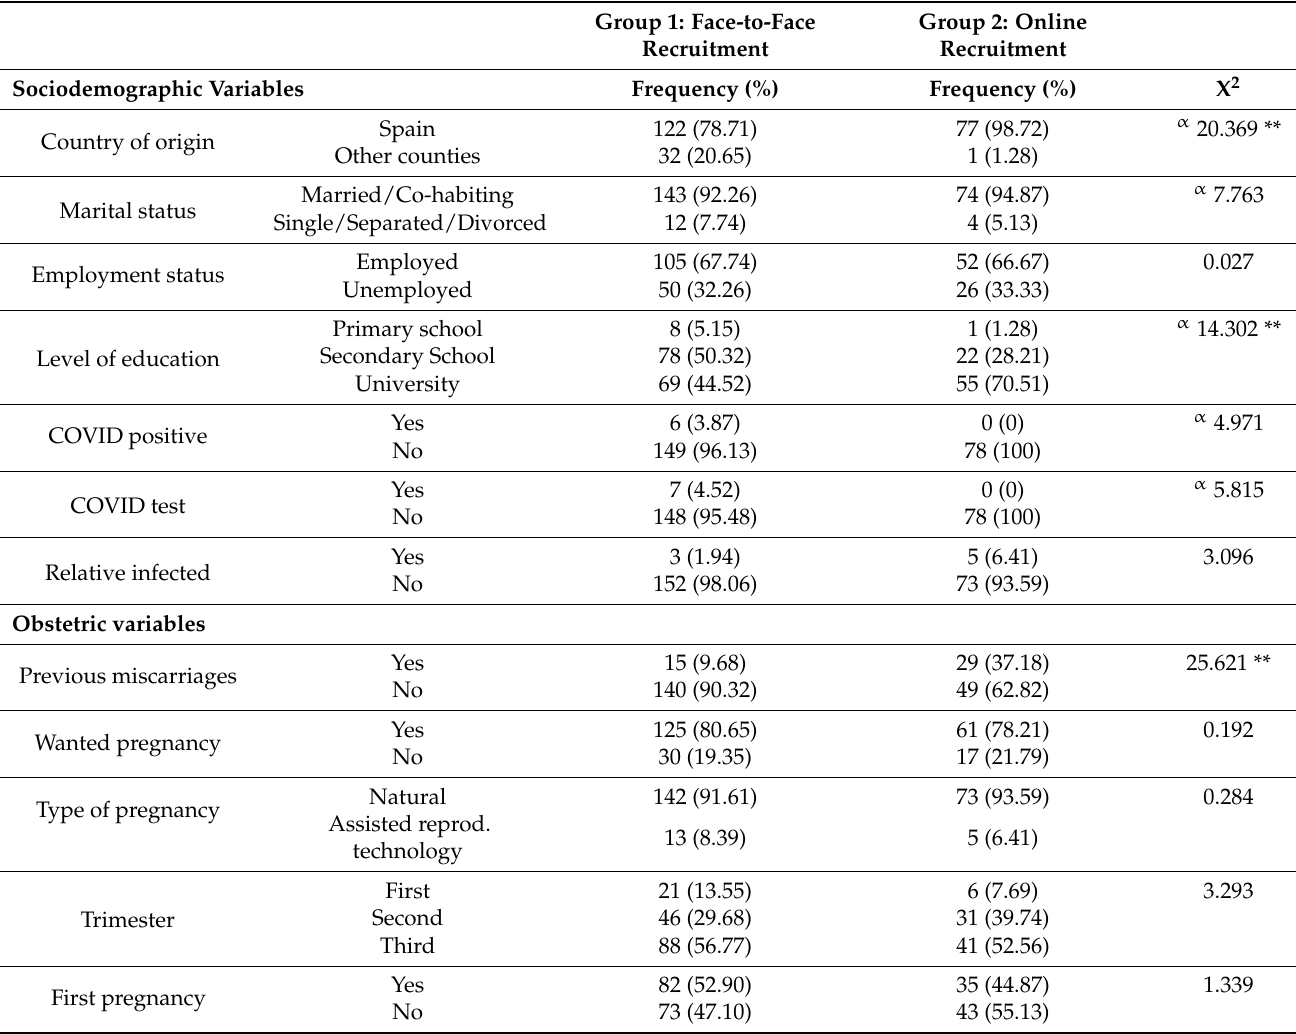
Table 1. Sociodemographic and obstetric characteristics of participants (N =